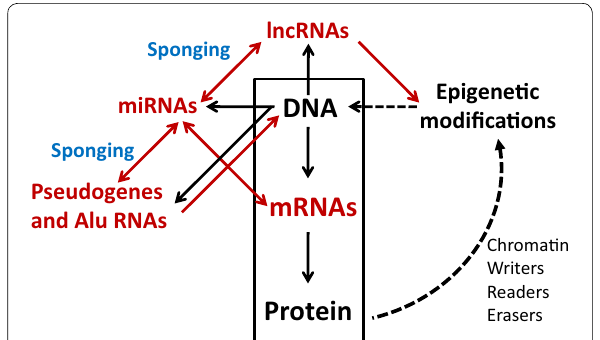
Fig. 1 The “central dogma” revisited. Shown are new additions to the central dogma (boxed), highlighting the fundamental role of miRNAs in the regulation of gene expression. This work reviews the functional relationships among the RNAs drawn in red. Black arrows means transcription or translation, double-headed red arrows mean mutual interactions, red arrows functional interactions (in the case of pseudogenes and Alu elements, retroinsertion) and dotted lines refer to the histone code and chromatin